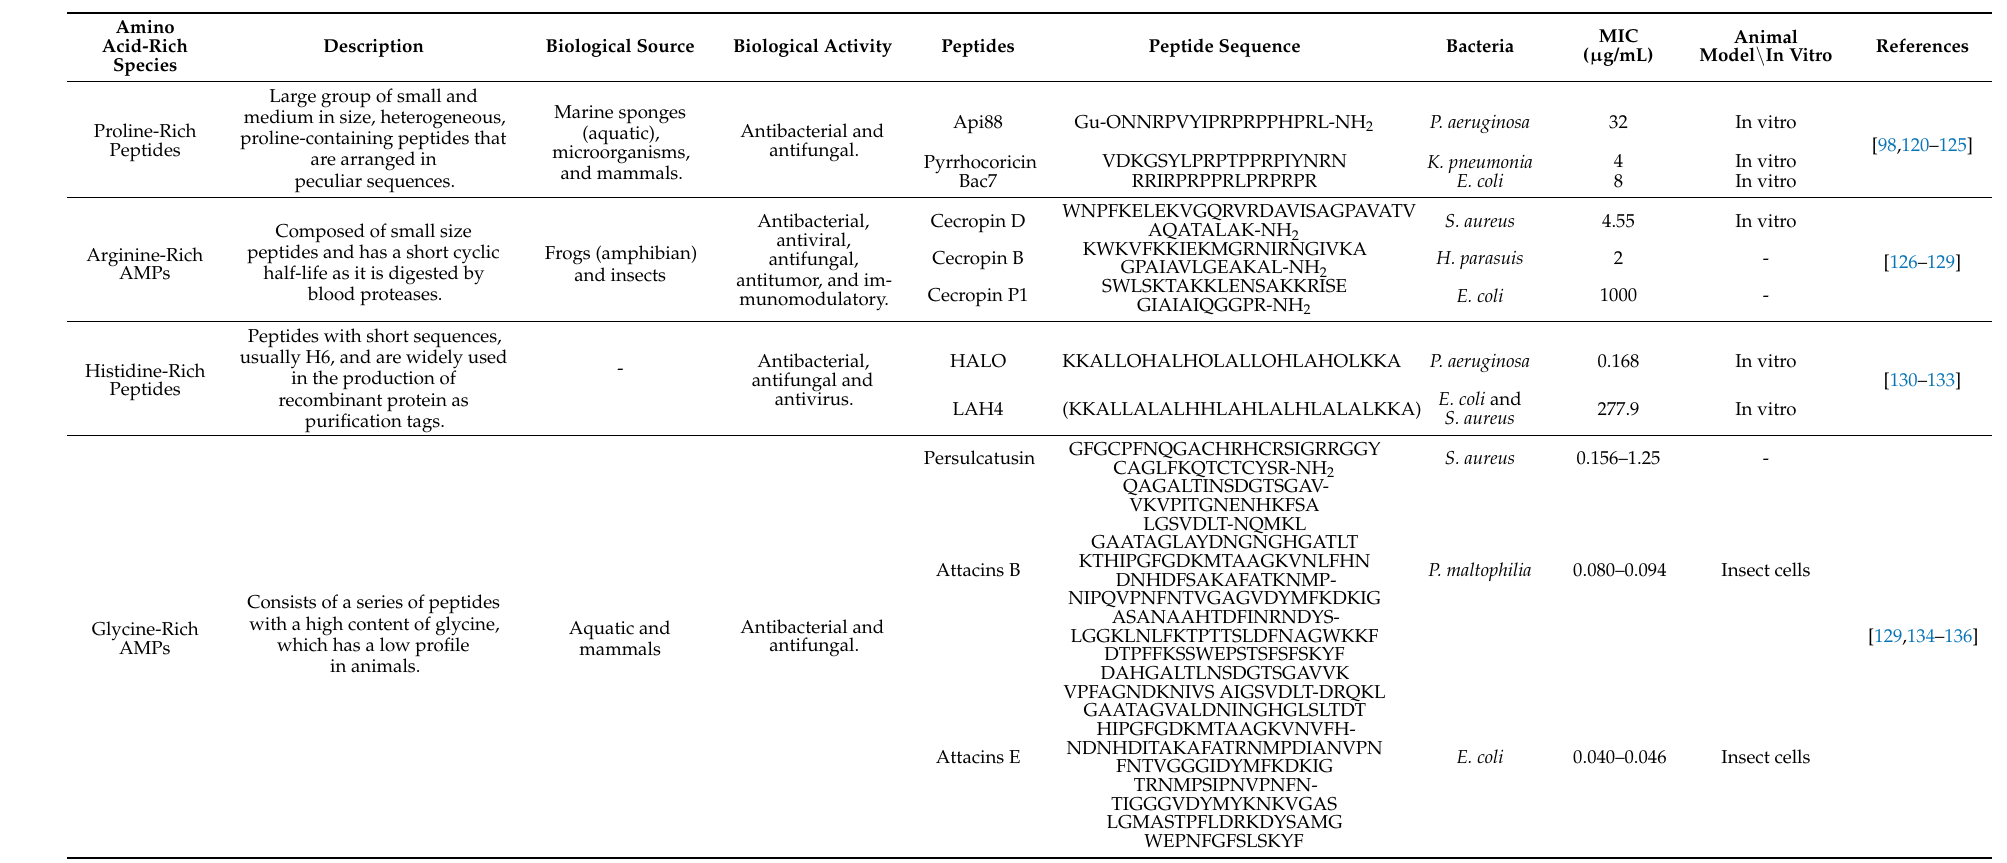
Table 2. Classification of the AMPs based on amino acid-rich species, biological source, and biological